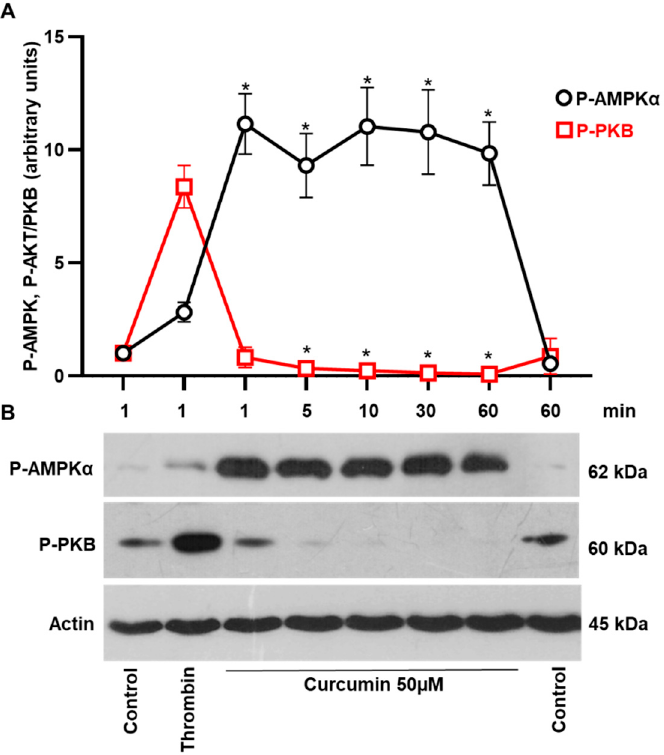
Figure 3. Curcumin stimulates AMPK and inhibits PKB activity in platelets. Washed platelets (3 × 10 8 cells/mL) were incubated with curcumin (50 µM) for the indicated time and analyzed by Western blotting for total actin, AMPK, and PKB phosphorylation. Thrombin (0.01 U/mL, 1 min) was used as a positive control for PKB and AMPK phosphorylation. ( A ) Quantitative analysis of PKB and AMPK phosphorylation. Immunoblots were scanned and quantified by the Image J program. The intensity of the P-AMPK and P-PKB signal was normalized to the actin signal. For each sample, this ratio is relatively expressed to the ratio for control, which is presented as 1. Data are presented as means ± SD. One-way ANOVA, Levene’s test p > 0.05 followed by Tukey’s HSD test for P-AMPK and Levene’s test p < 0.05 followed by Tamhane’s T2 test for P-PKB. For P-AMPK * as appeared in the figure p = 0.0001; 0.0001; 0.0001; 0.0001; 0.0001, n = 4. For P-PKB * p = 0.049; 0.012; 0.02; 0.001 ( n = 5), compared to controls taken as 1 in both cases. ( B ) Representative Western blots of PKA and AMPK